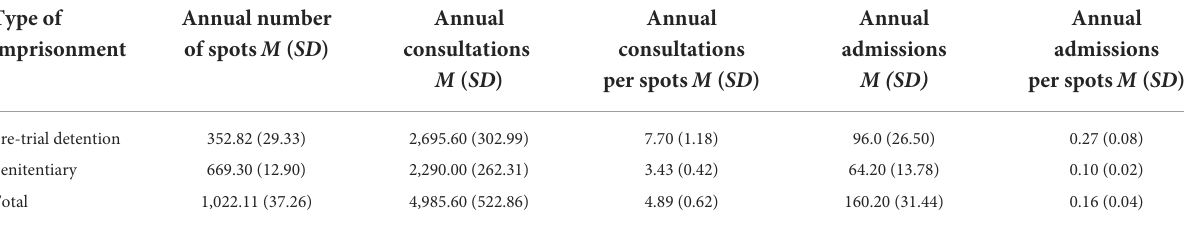
TABLE 2 Annual primary psychiatric care consultations and psychiatric hospital admissions between 2014 and 2018 by type of correctional setting.